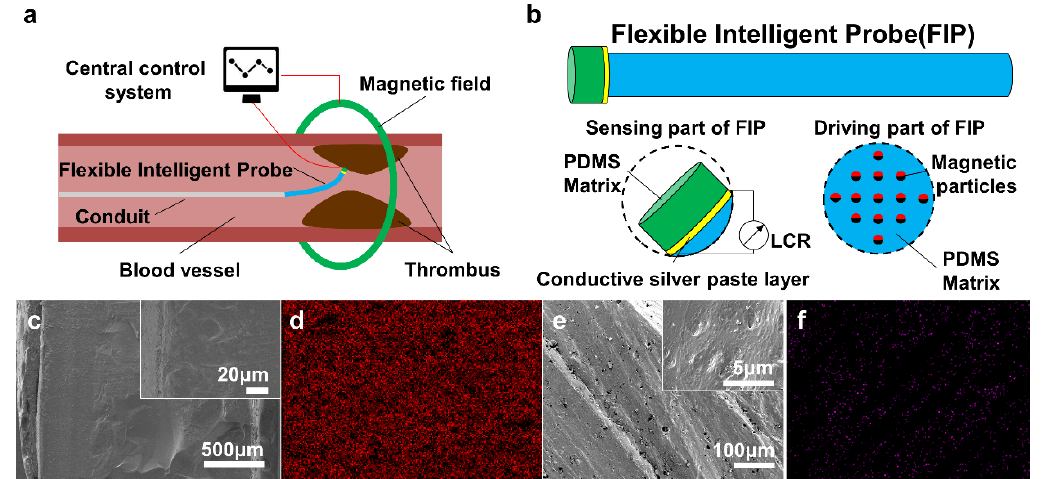
Figure 1. Model and characterization of the flexible intelligent probe (FIP). ( a ) Working model diagram of FIP, ( b ) Composition model diagram of FIP, ( c ) SEM images of cross-section of the piezo-resistive sensing part, ( d ) Element distribution of the piezo-resistive sensing part, ( e ) SEM images of cross-section of the magnetic driving part; ( f ) Element distribution of the magnetic driving part.